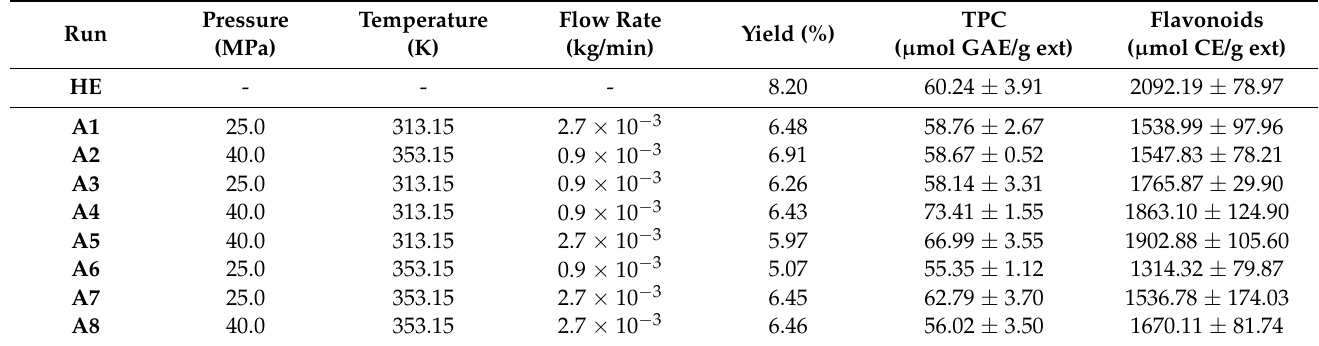
Table 1. FFD design tests results and the response functions evaluated in each